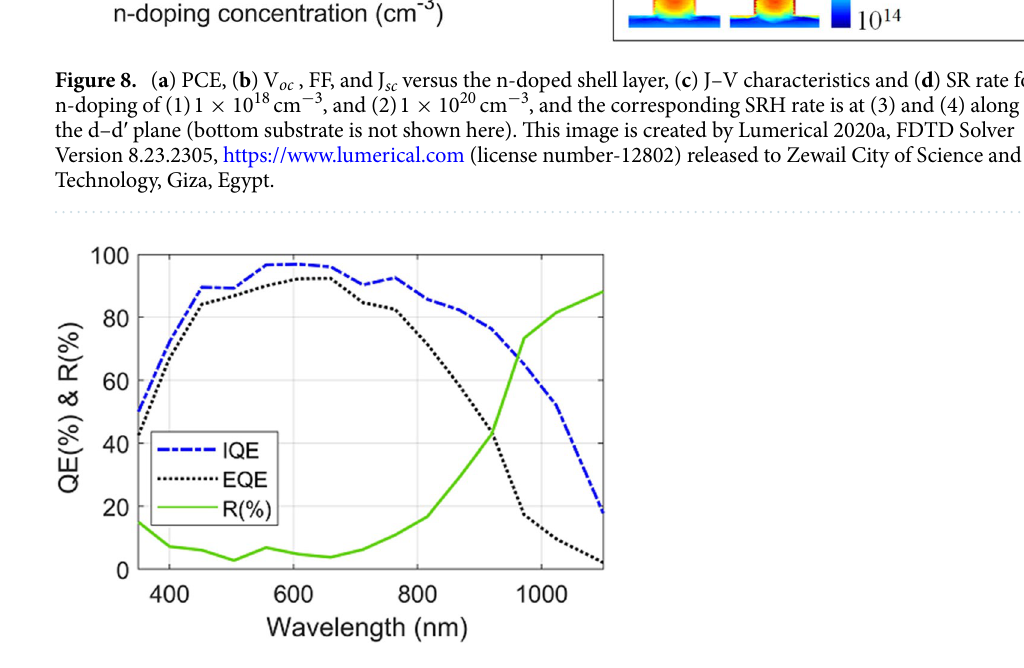
Figure 9. The Quantum efficiency (QE), and the Reflection loss in (%) versus the light